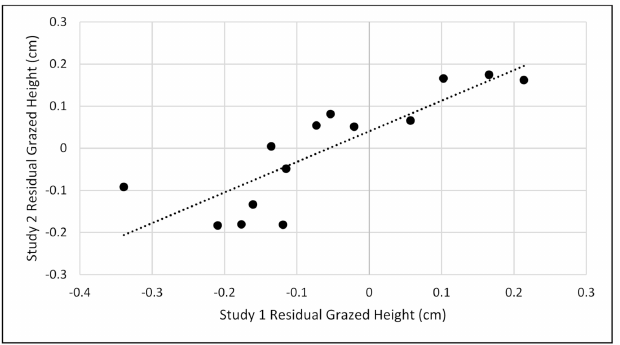
Figure 1. Relationship between varieties common to Study 1 and Study 2 for residual grazed height ( r =